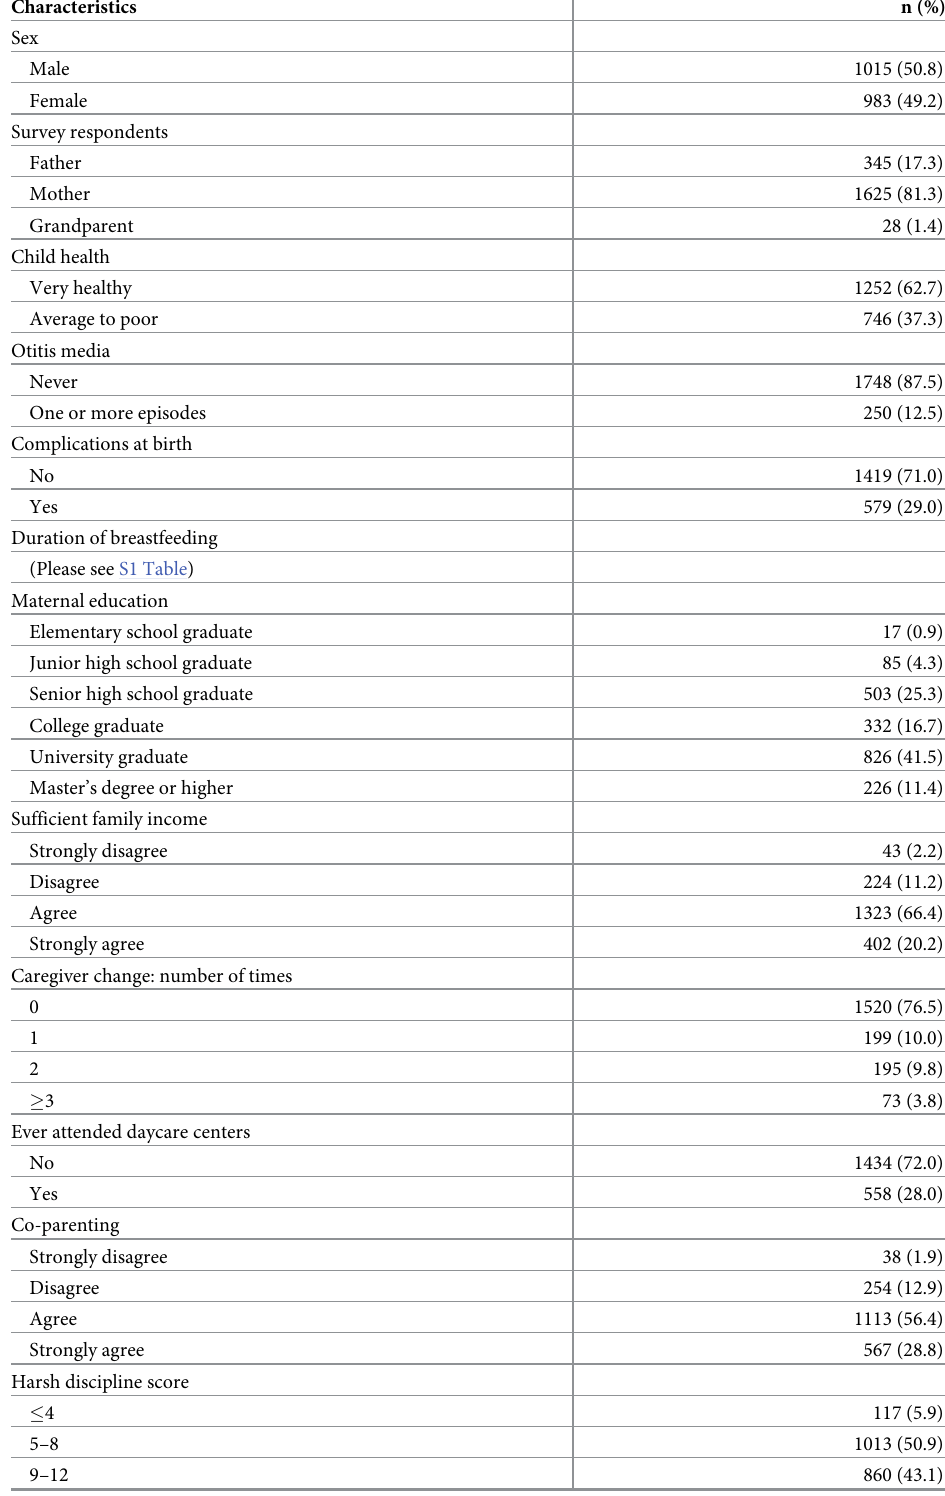
Table 1. Selected baseline characteristics of the study